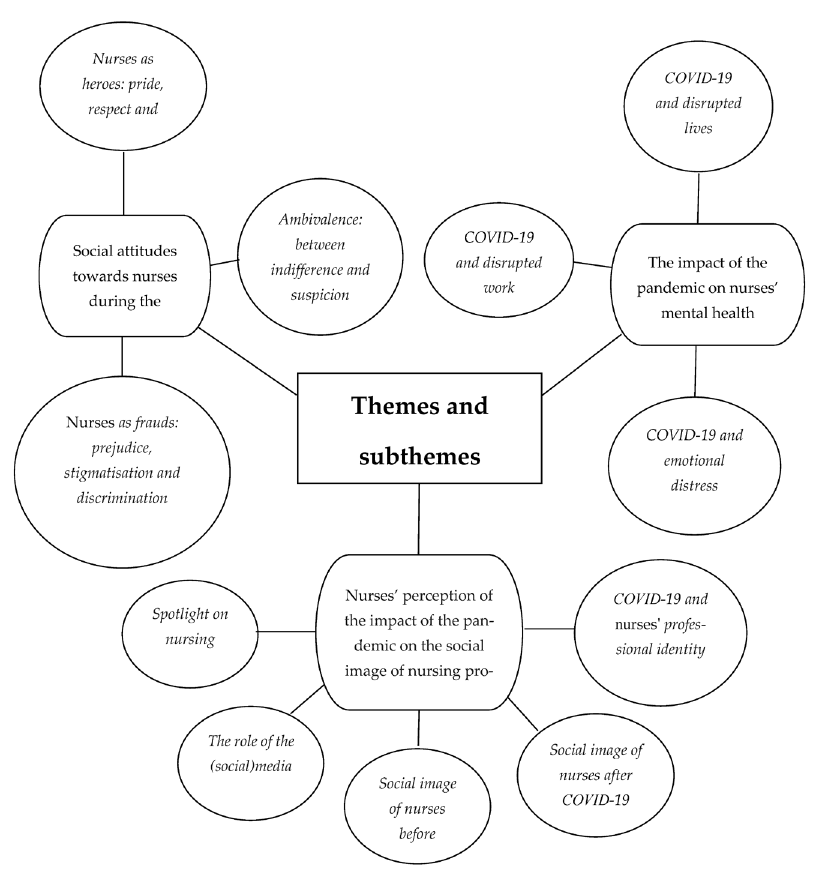
Figure 1. Themes and subthemes emerging from qualitative analysis.